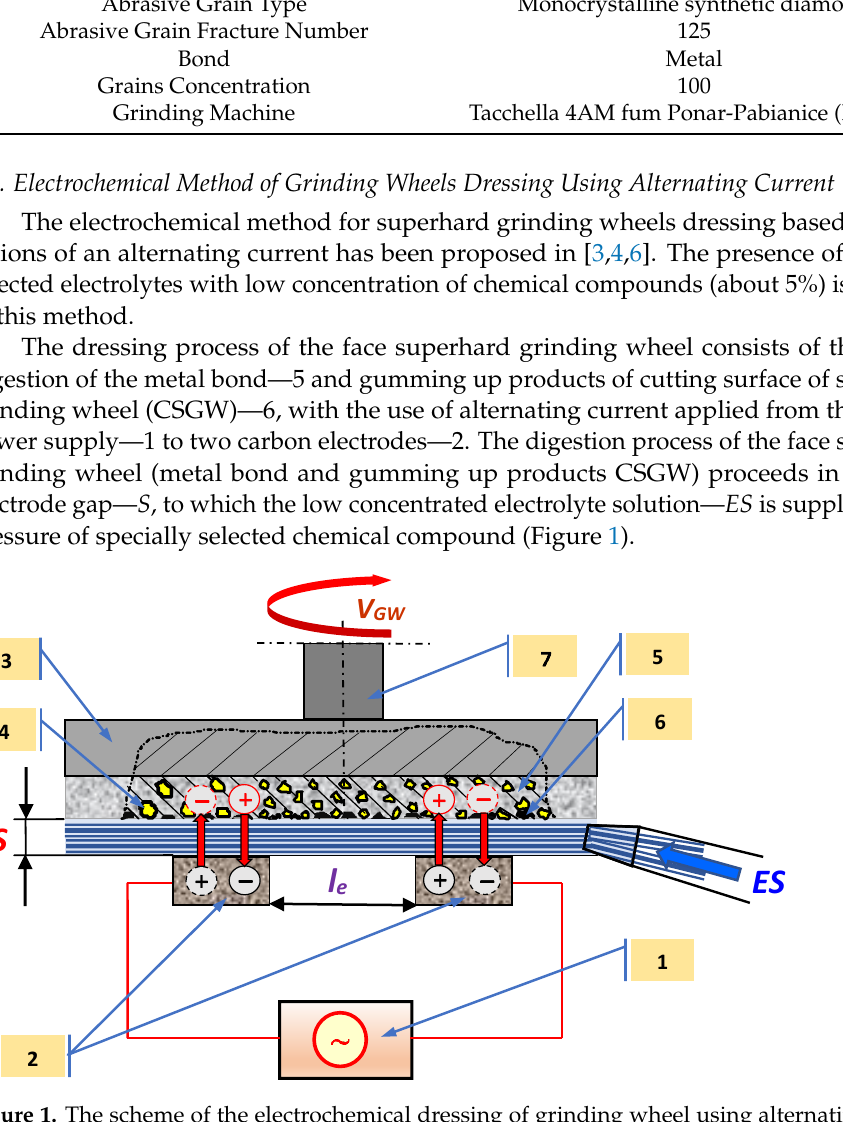
Figure 1. The scheme of the electrochemical dressing of grinding wheel using alternating current (ECDGW-AC): 1 — alternating current power supply, 2 — carbon electrodes, 3 — grinding wheel frame, 4 — abrasive grains, 5 — metal bond, 6 — gumming up products of cutting surface of super- hard grinding wheel (CSGW), 7 — spindle; V GW — speed of grinding wheel, S — inter-electrode gap, l e — distance between electrodes, ES — electrolyte solution of specially selected chemical com- pounds.